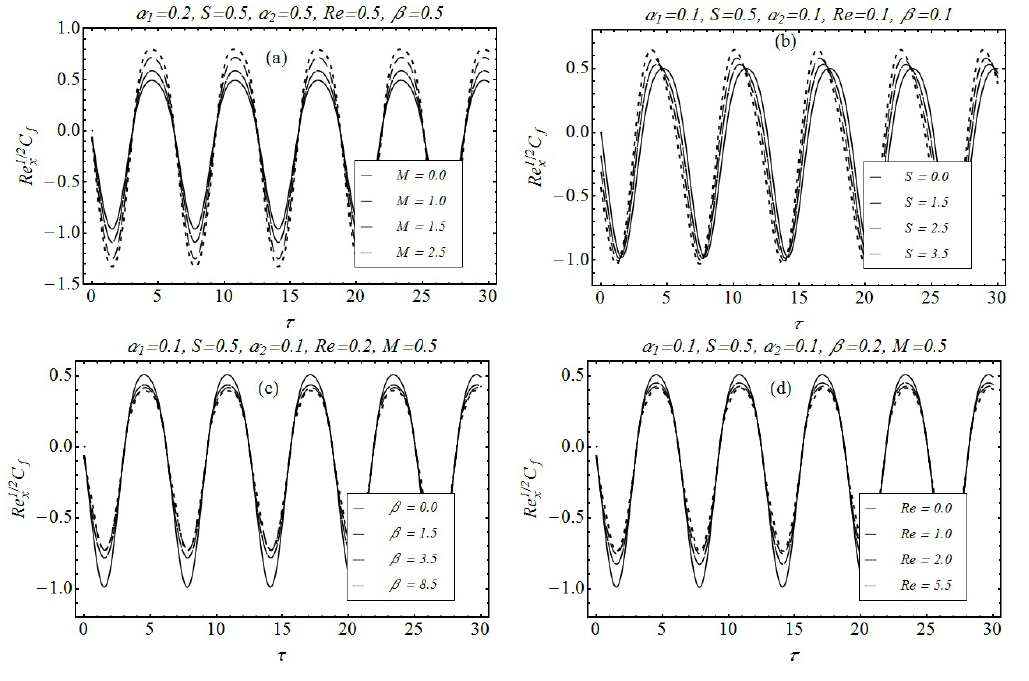
Figure 8: Time series of skin friction coeflcient (a) effects of M (b) effects of S (c) effects of β , (d) effects of Re .